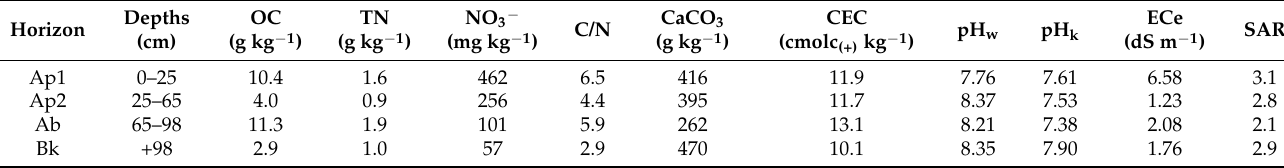
Table 2. General profile